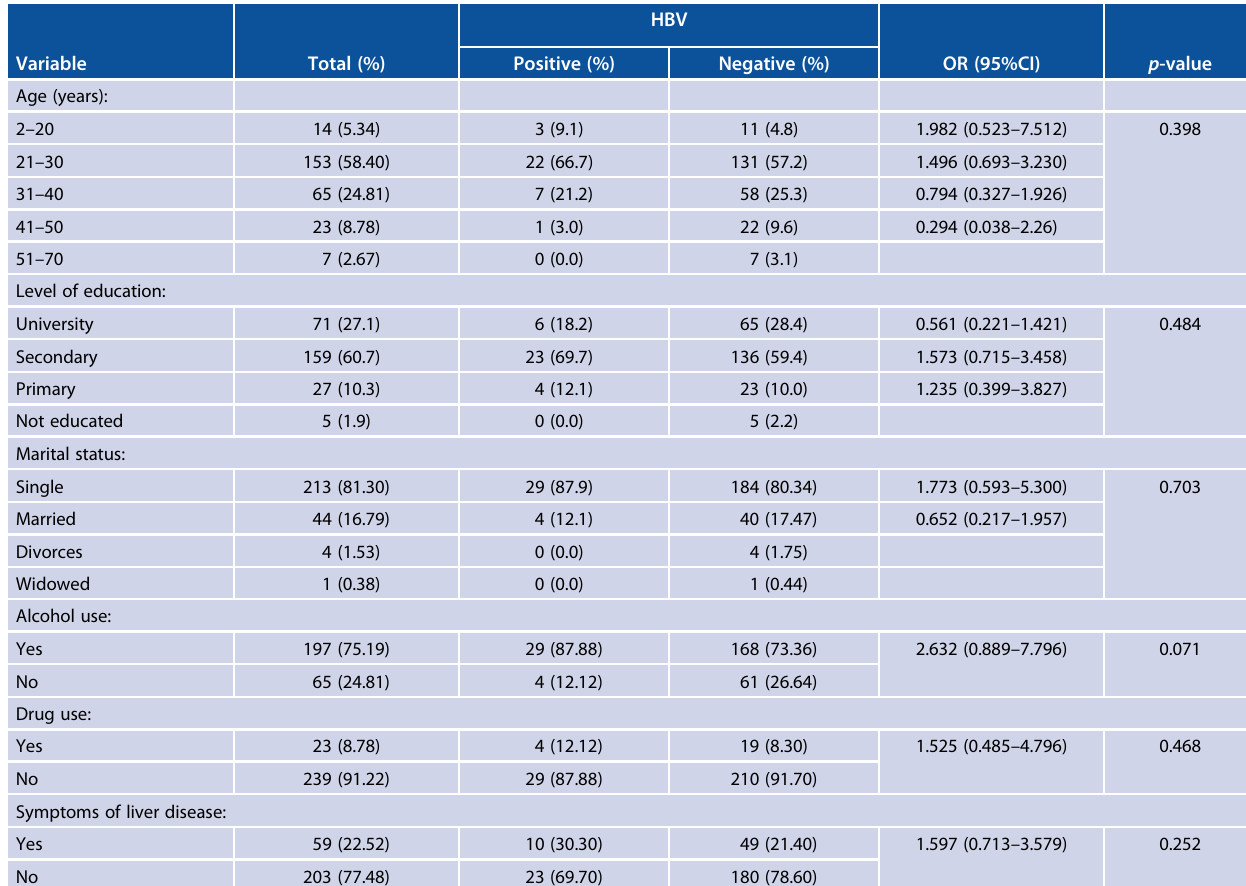
Table 4: Potential risk factors for HBV infection among barbers and their clients